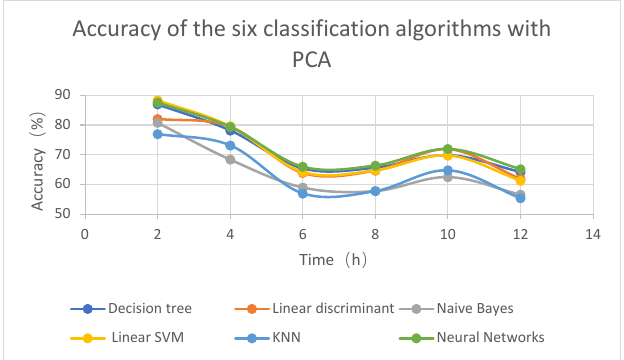
Figure 3. Accuracy of the six classification algorithms with PCA. Table 3. Accuracy of the six classification algorithms without PCA.